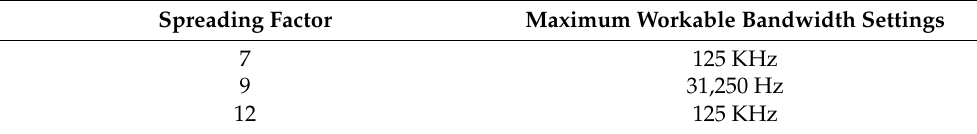
Table 2. Spreading factors and maximum workable bandwidth